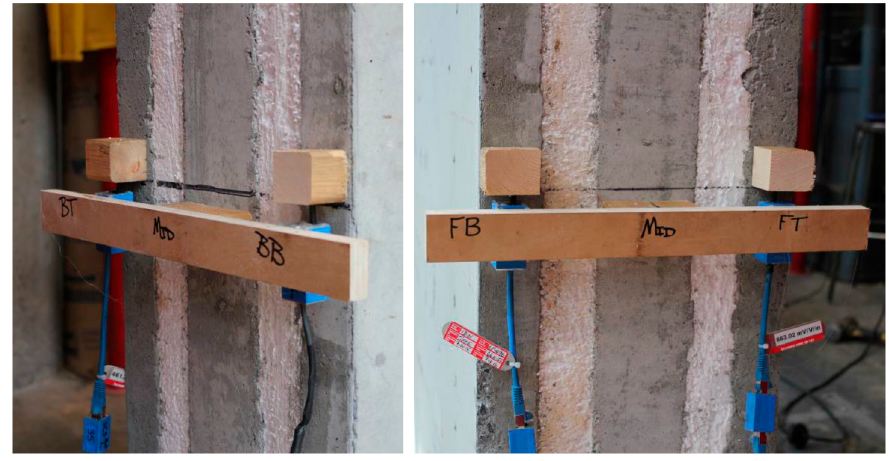
Figure 6. A typical panel with potentiometers installed.